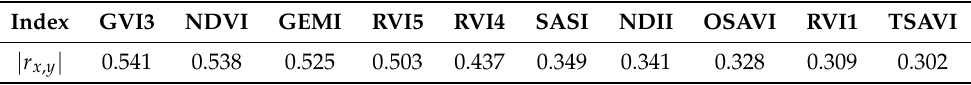
Table 5. Conventional vegetation indices (Table 2) with the best performance for the combined data from both watersheds. Performance was measured by using the correlation factor ( | r x , y |